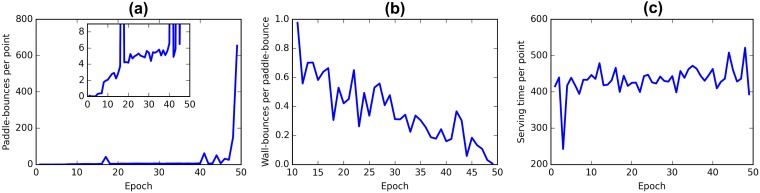
Evolution of the behavior of the collaborative agents during training.(a) The number of paddle-bounces increases as the players get better at reaching the ball. (b) The frequency of the ball hitting the upper and lower walls decreases significantly with training. The first 10 epochs are omitted from the plot as very few paddle-bounces were made by the agents and the metric was very noisy. (c) Serving takes a long time—the agents learn to postpone putting the ball into play.